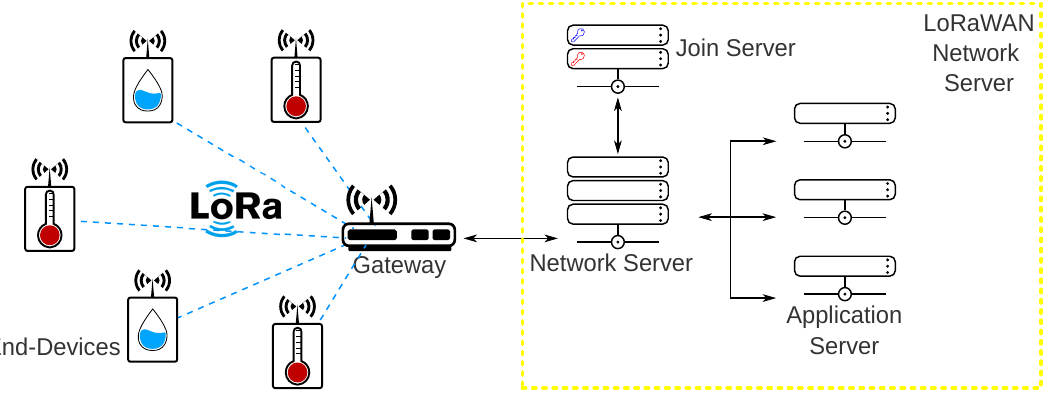
Figure 2. Typical LoRaWAN